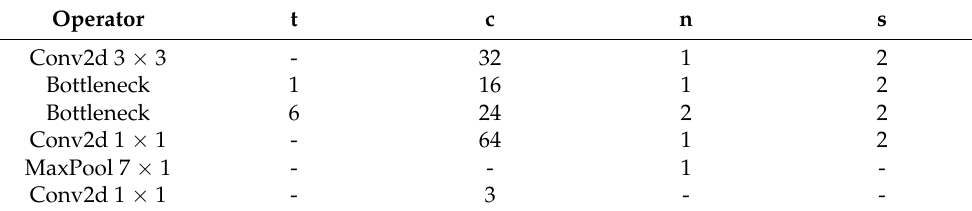
Table 4. Structure of Tiny MobileNet V2: each line describes a sequence that repeats the same layer n times. All layers in the same sequence have the same number c of output channels. The module repeats stride s for the first time, and all others use stride 1. The expansion factor t is always applied to the input